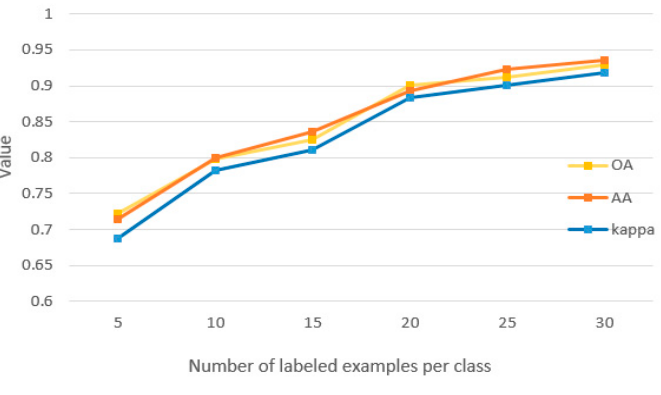
Figure 30. OA, AA, and kappa under different numbers of labeled examples per class.